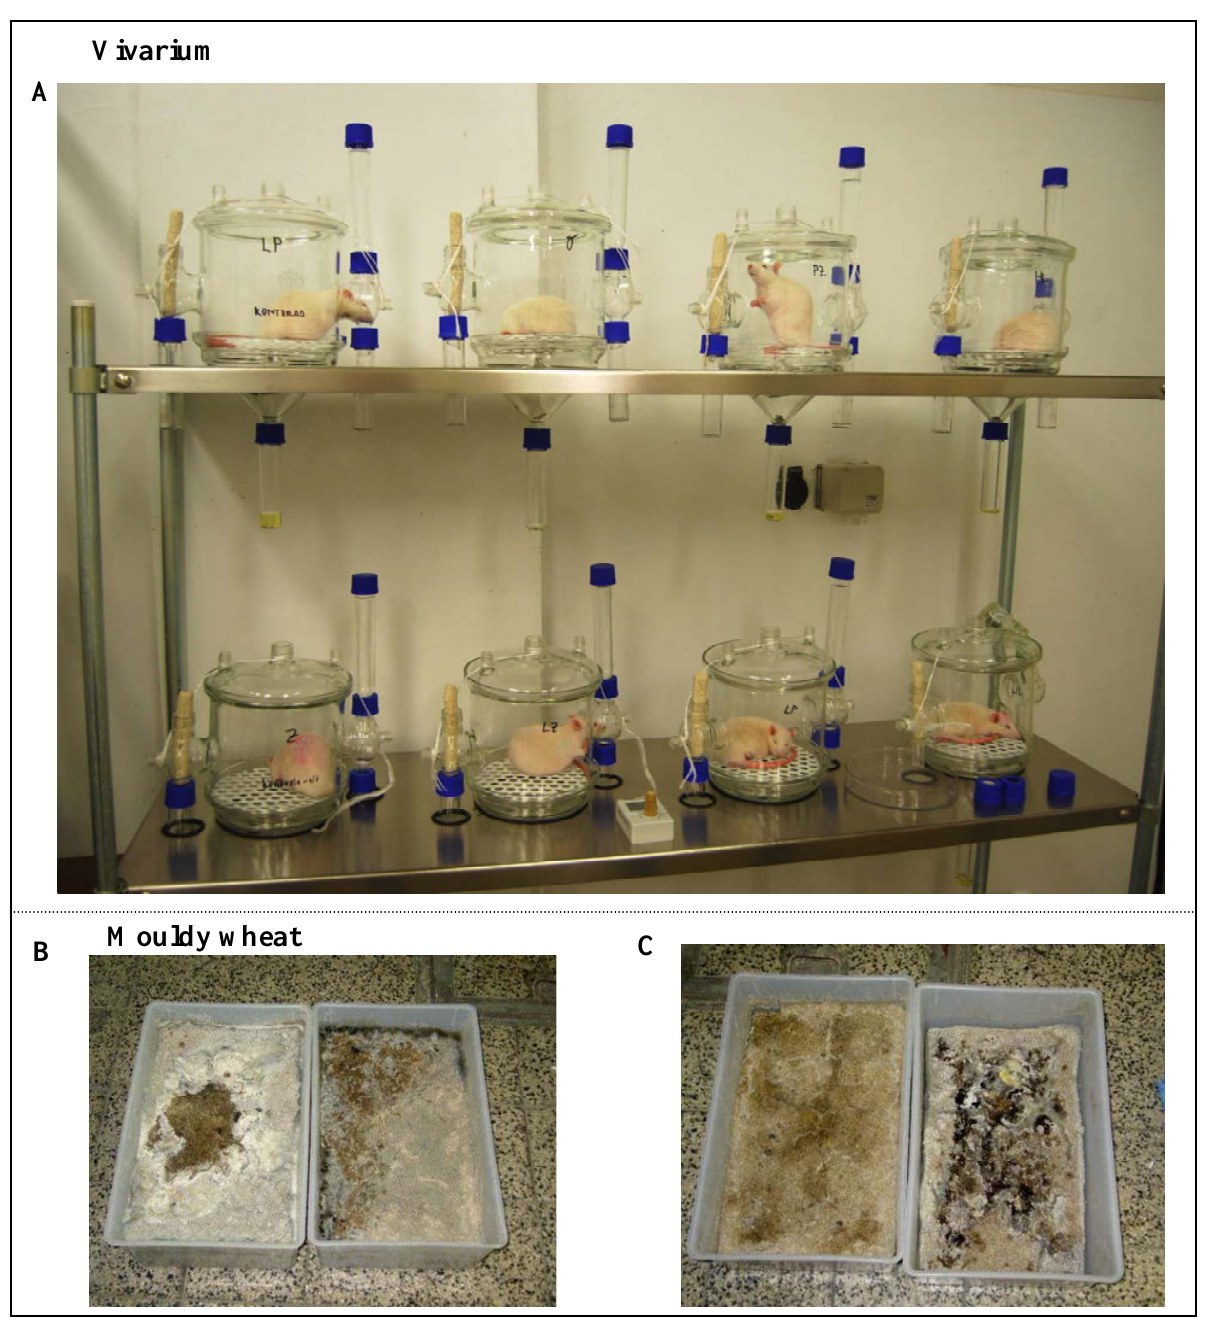
Figure 3. (A) Vivariums for rats with weight under 150 g. (B) Naturally mouldy wheat after fourteen or (C) twenty eight days of